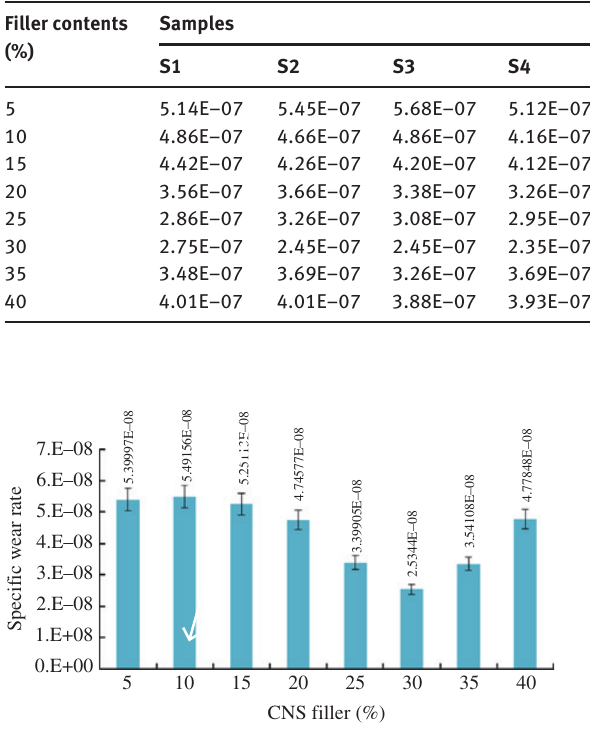
Figure 6: Specific wear rates of the untreated CNS filler epoxy com- posites with various filler contents.